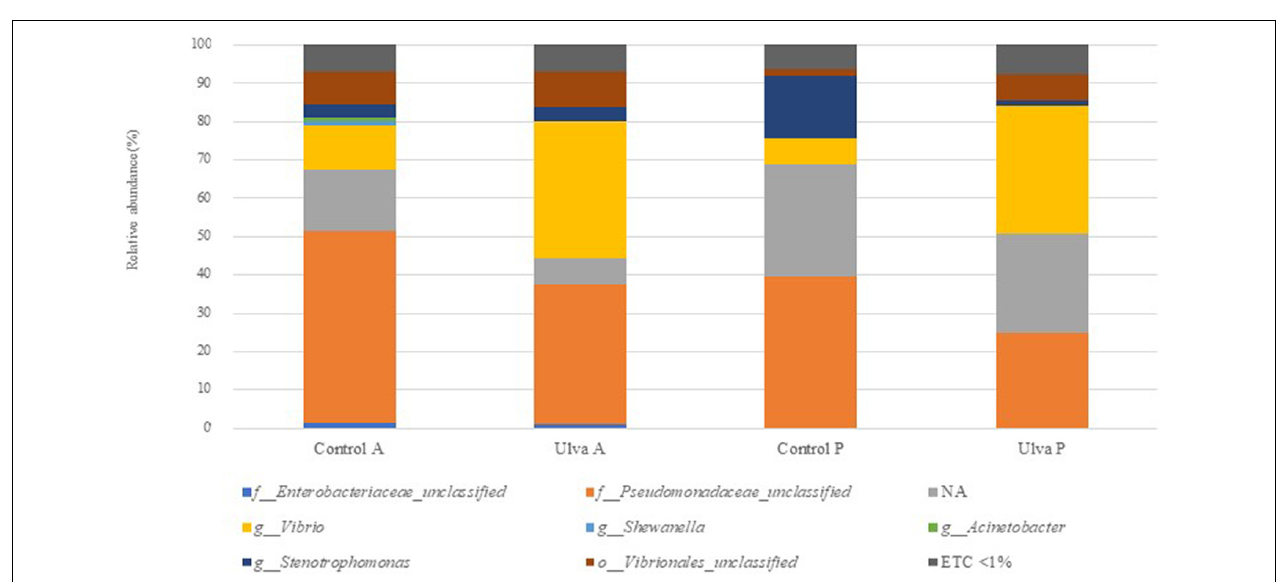
FIGURE 3 | Average of the samples of gut microbiota (relative OTU composition) at family level of the gastrointestinal tract of S. senegalensis fed control (Control) and Ulva ohnoi supplemented (Ulva) diets for 90 days. A, anterior section; P, posterior section. ETC < 1% indicates relative abundance below 1%.